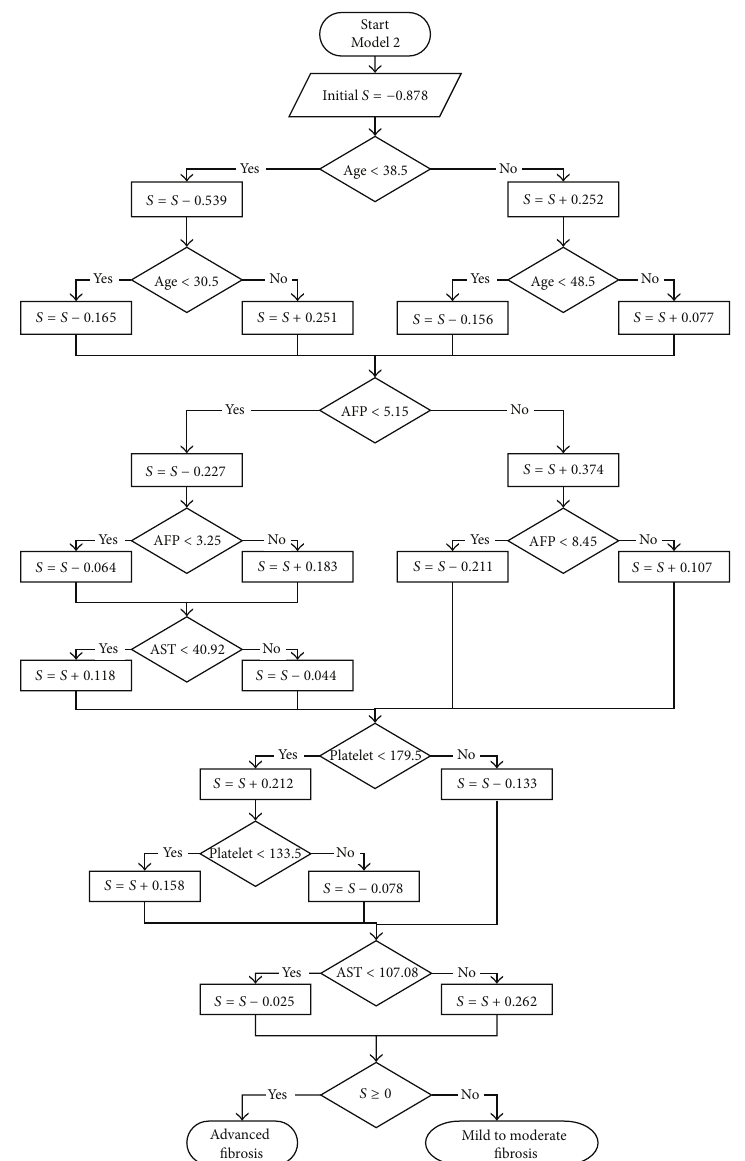
Figure 2: Flowchart of model 2. 𝑆 represents the fibrosis score of the patient. If final 𝑆 ≥ 0 , then the patient has an advanced fibrosis and vice versa.